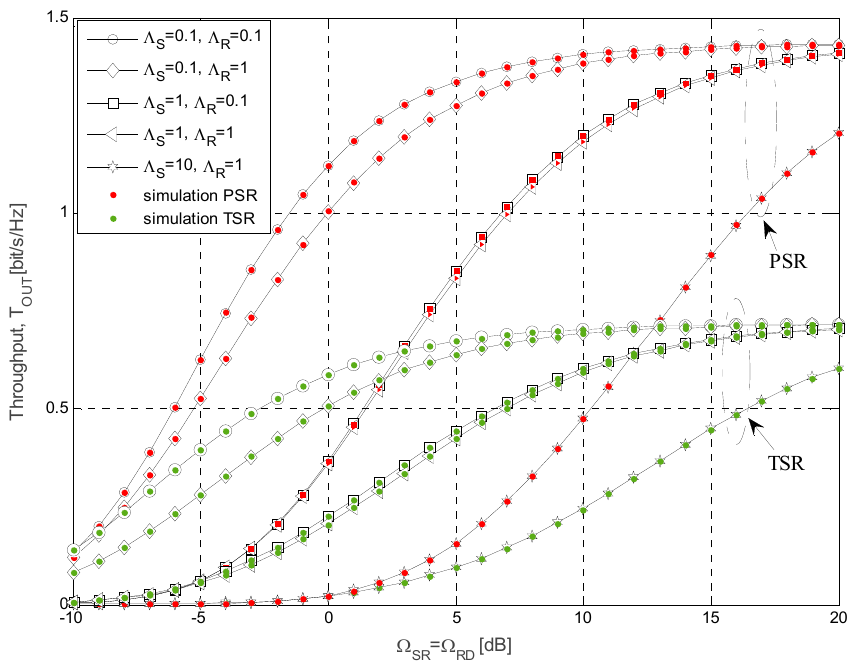
Figure 5. Throughput for different values of mean channel power gain in a cognitive relay system.